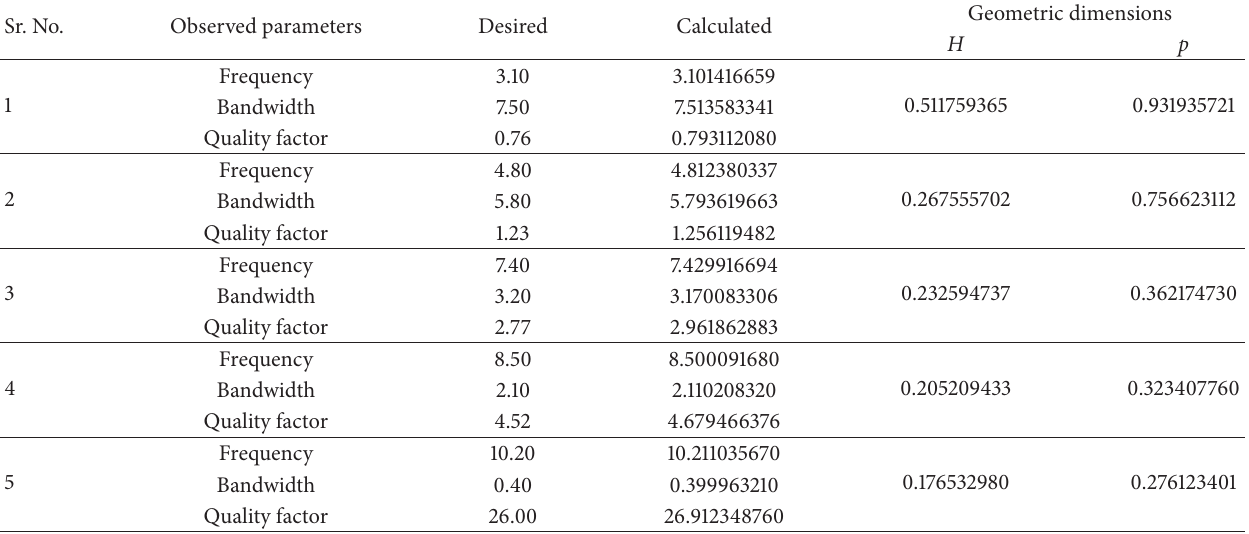
Table 3: Optimized values for PHMA at the lower frequency of 3.1, 4.8, 7.4, 8.5, and 10.2 GHz. Sr.